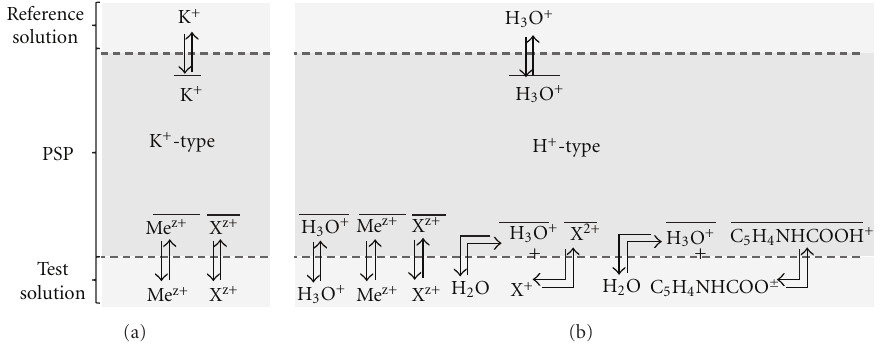
Figure 3: The quasiequilibria at the interface of PSP in K-type (a) and H + -type (b) with test and reference solutions in PD sensor: X + is lysine, thiamin, and novocaine cations, Me z+ is cations of alkaline, and alkaline-earth metals.